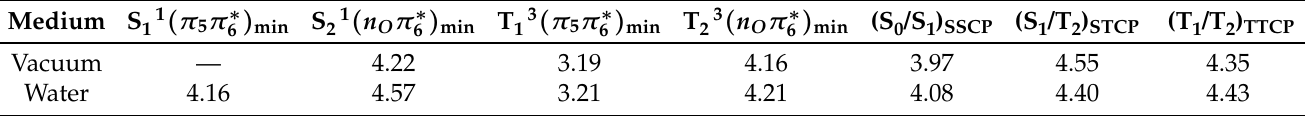
Table 3. Adiabatic energies (eV) relative to the ground state minimum in vacuum and water.